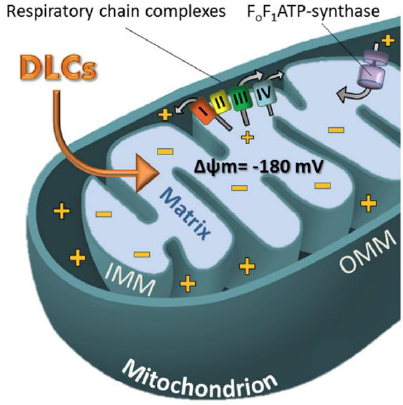
Figure 19. Uptake mechanism of DLCs in the mitochondrion. ( ∆ ψ m: mitochondrial membrane potential; I, II, III, IV: complexes related to the mitochondrial respiratory chain; IMM: inner mitochon- drial membrane; OMM: outer mitochondrial membrane). (Reprinted with permission from ref. [85]. Copyright 2018 Elsevier).